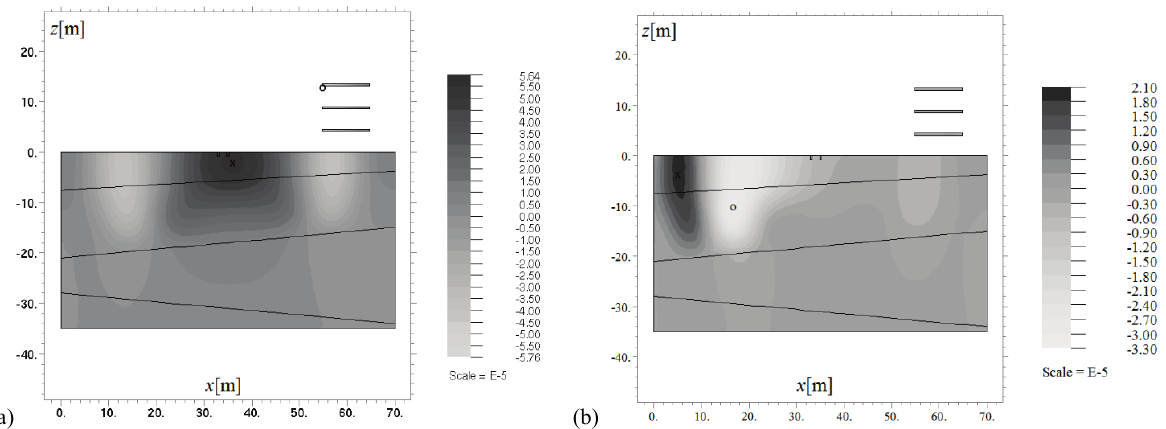
Fig. 4. Displacement component in z -direction in [m] for y = 35 m, t = 0.125